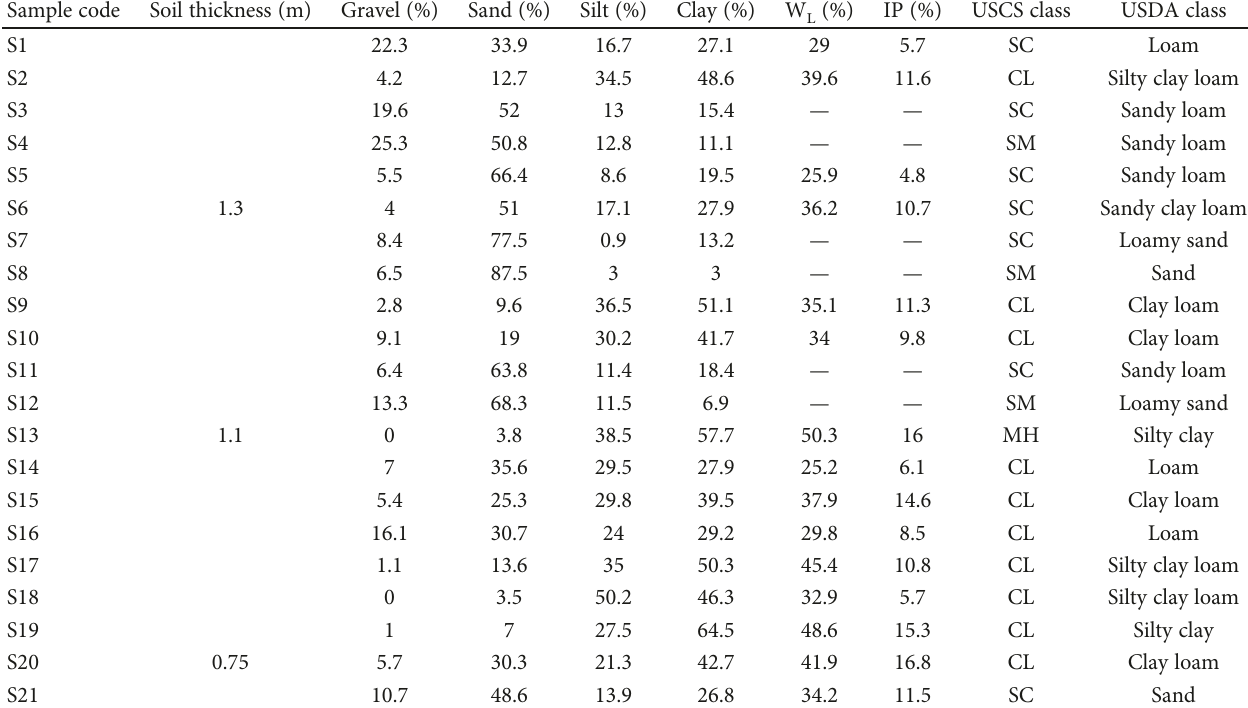
Table 1: Physical properties and corresponding USCS-USDA class for the 21 samples collected on Monte Mario Hill. Sample